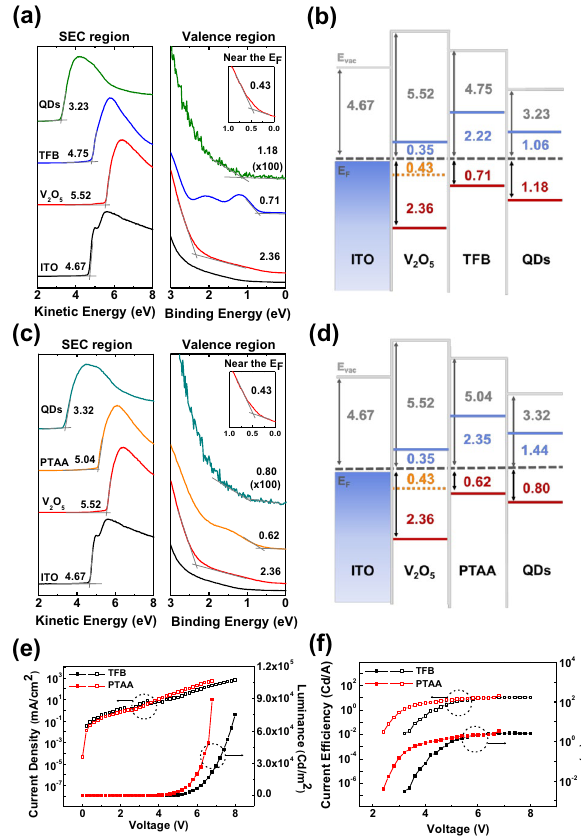
Figure 4. UPS spectra at the SEC, valence, and near the E F regions. ( a ) ITO, ITO/V 2 O 5 , ITO/V 2 O 5 /TFB, and ITO/V 2 O 5 /TFB/QDs. ( c ) ITO, ITO/V 2 O 5 , ITO/V 2 O 5 /PTAA (UVO 40), and ITO/V 2 O 5 /PTAA (UVO 40)/QDs. Energy level diagram of ( b ) ITO/V 2 O 5 /TFB/QDs and ( d ) ITO/V 2 O 5 /PTAA (UVO 40)/QDs. Performance of the QLEDs with UVO 40 and TFB HTLs. ( e ) J-V-L and ( f ) CE-V-EQE